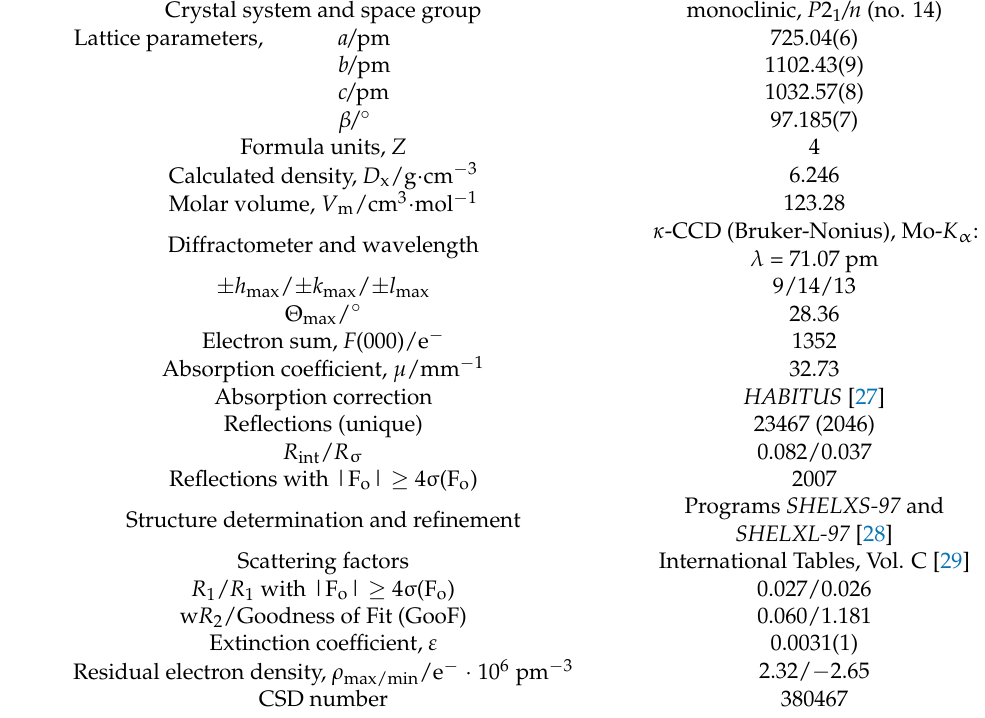
Table 1. Tm 3 F[Si 3 O 10 ]: Crystallographic data and details of the structure refinement. Crystal system and space